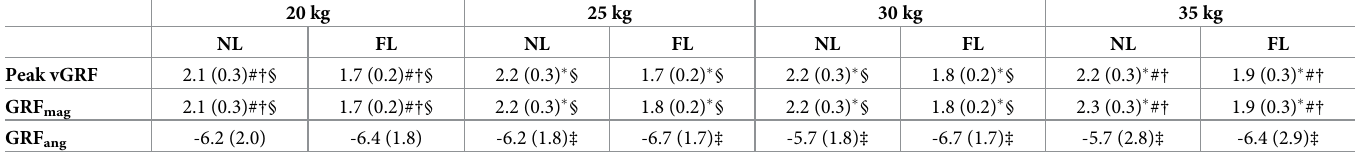
Table 3. Mean (SD) peak vGRF (BW), GRF mag (BW) and GRF ang (˚) during normal (NL) and flexed (FL) drop landings.